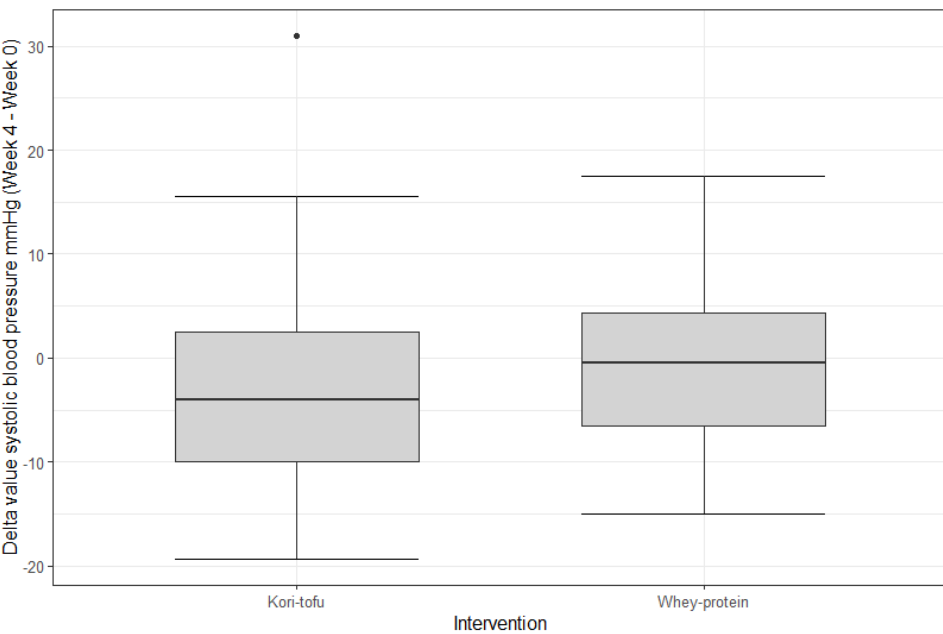
Figure A6. Delta values of systolic blood pressure (mmHg) per intervention (values week 4–values week 0). Boxplots represent the 25th, 50th (median) and 75th percentile. Antennas represent 1.5 times interquartile range. Dots represent values outside the 1.5 times interquartile range.